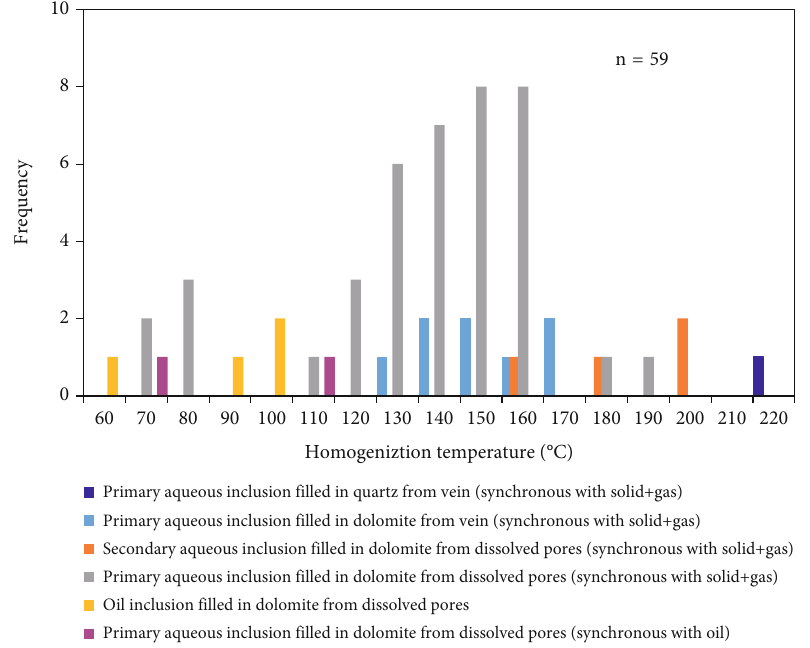
Table 3: The parameters for model construction, Well MX20. Formation